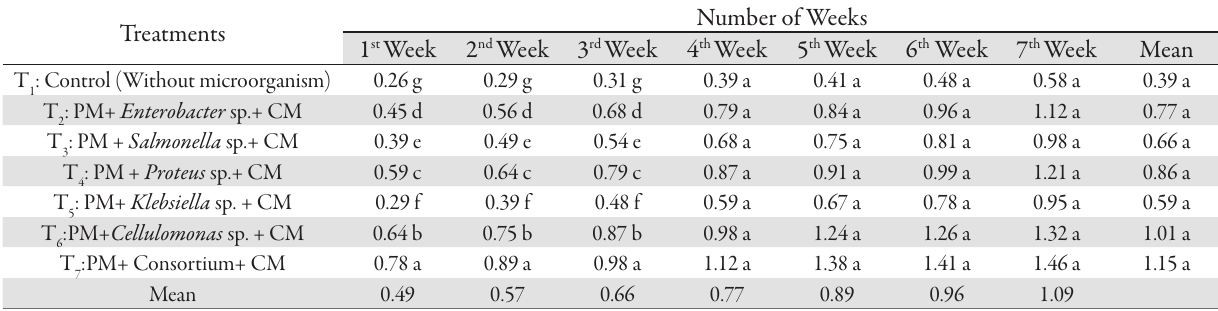
Number of Weeks